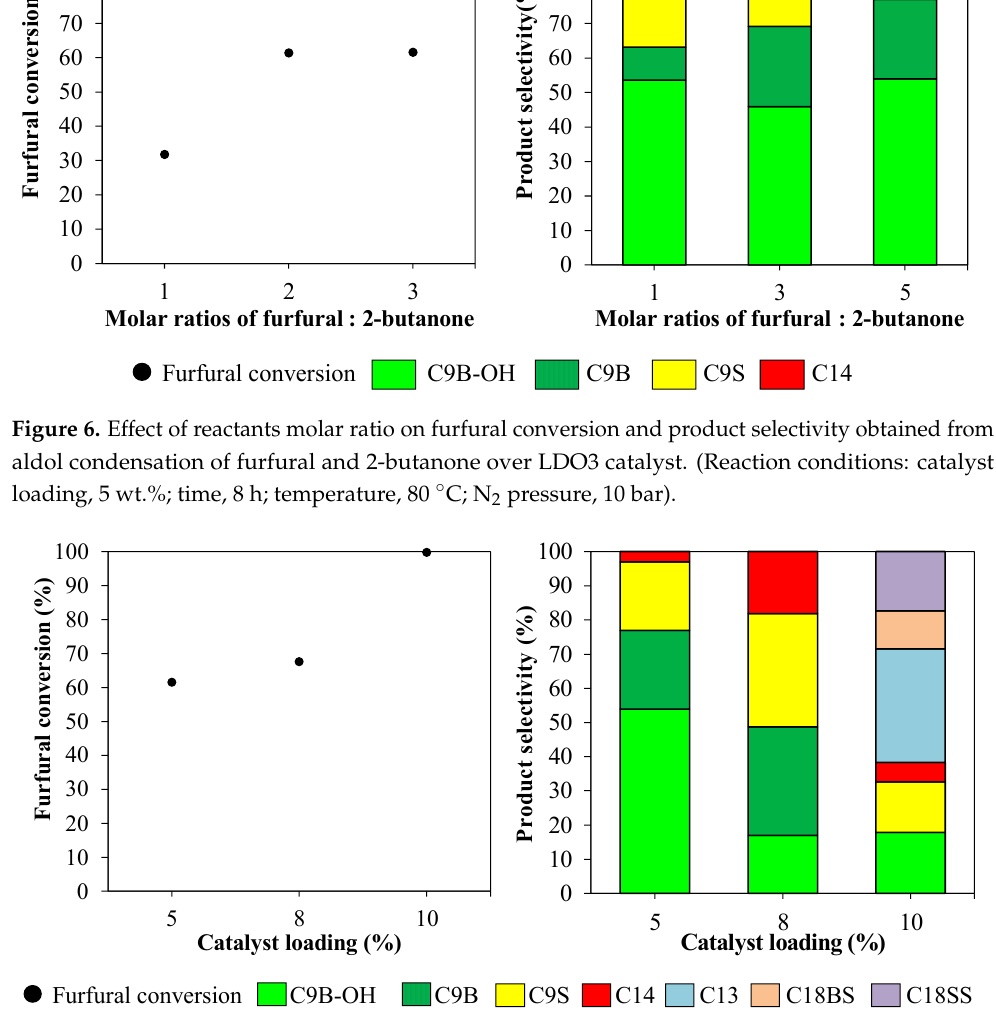
Figure 7. Effect of catalyst loading on furfural conversion and product selectivity obtained from aldol condensation of furfural and 2-butanone over LDO3 catalyst. (Reaction conditions: furfural:2-butanone, 1:5; time, 8 h; temperature, 120 ◦ C; N 2 pressure, 10 bar).